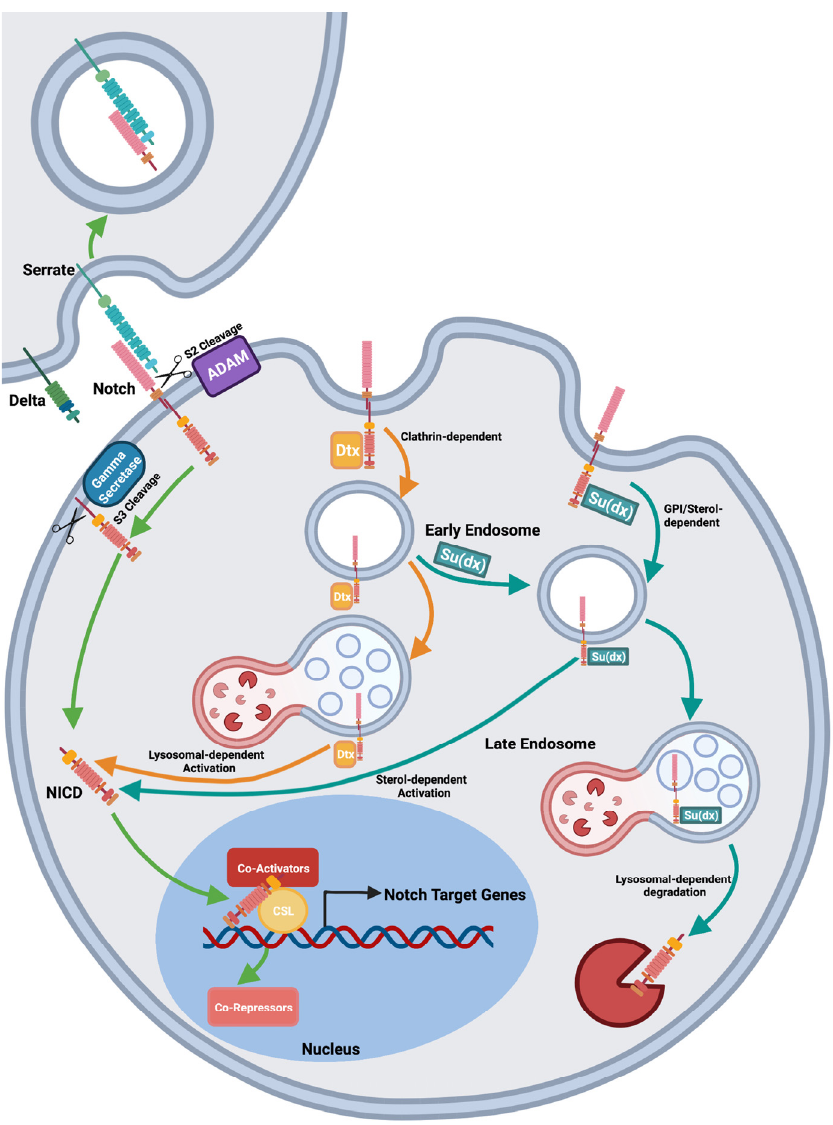
Figure 1. Pathways of Notch activation. Notch is activated by ligand-dependent or independent mechanisms [17]. At the cell surface Notch binds membrane-bound ligands. Endocytic-dependent force generation is thought to cause a conformational change that exposes the S2 cleavage site to ADAM10 dependent proteolysis, which sheds the extracellular domain. The remaining membrane tethered portion is cleaved by gamma-secretase to release the intracellular domain, which relocates to the nucleus and binds to the transcription factor CSL (CBF/Su(H)/Lag2) and coactivators